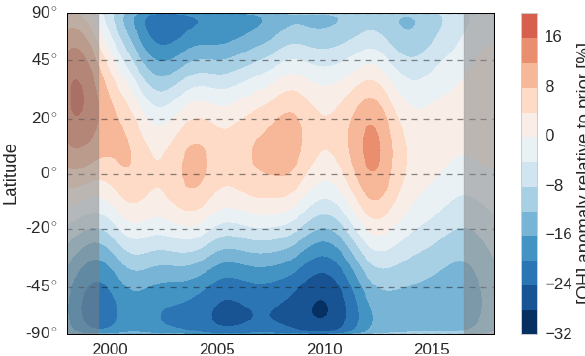
Figure 1. Monthly variations in global mean k(T ) · [OH], derived in the three different inversion setups. Variations in k(T ) · [OH] are calculated relative to the prior simulation, thus removing the influ- ence of interannual variations in temperature. Gray bars indicate a spin-up and spin-down period of 1.5 years.